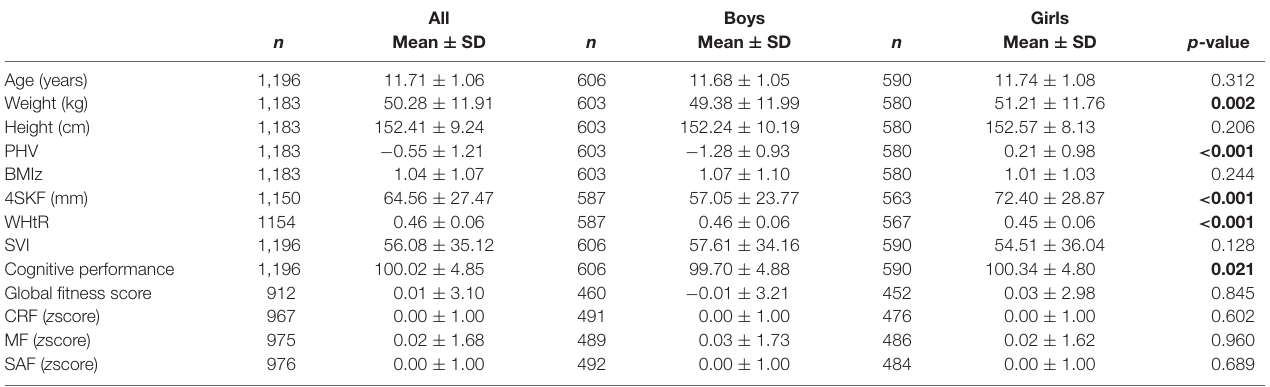
TABLE 1 | Participants’ characteristics.